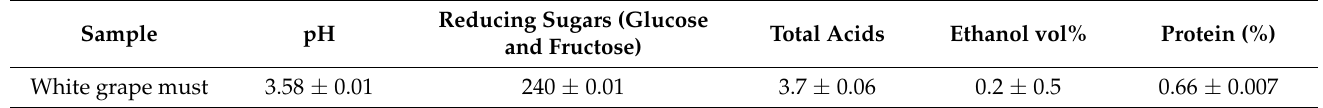
Table 4. Chemical analysis of white grape must, mean ± standard deviation values.